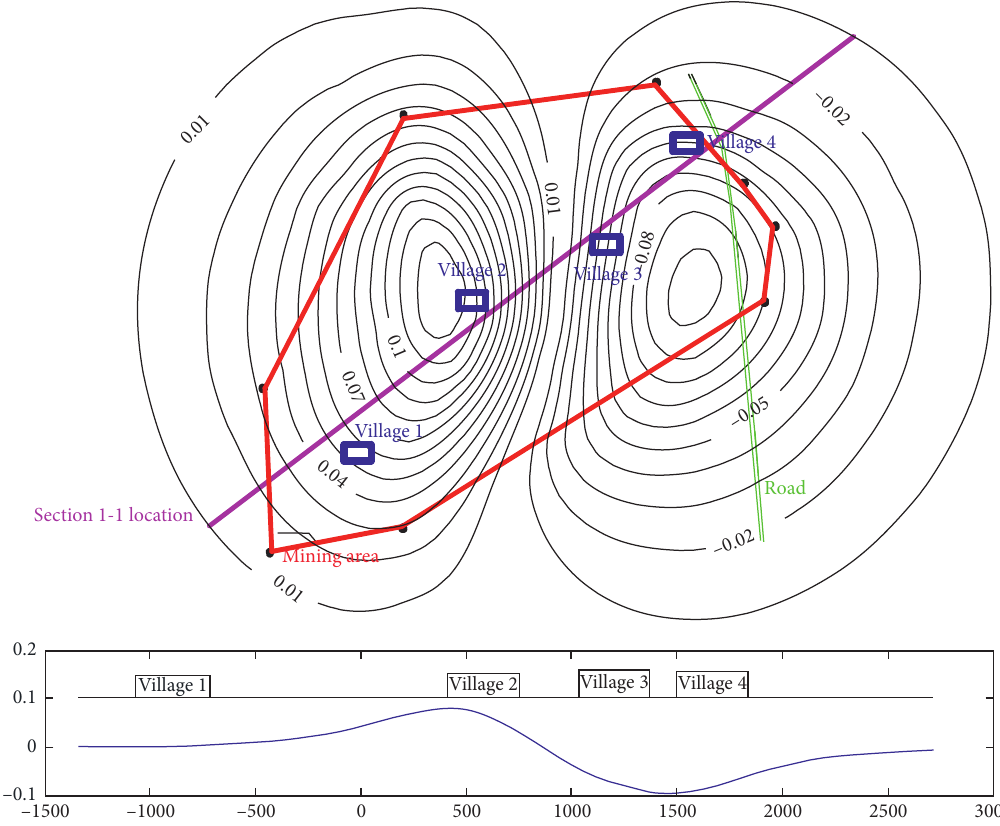
Figure 14: Contour map of horizontal movement.